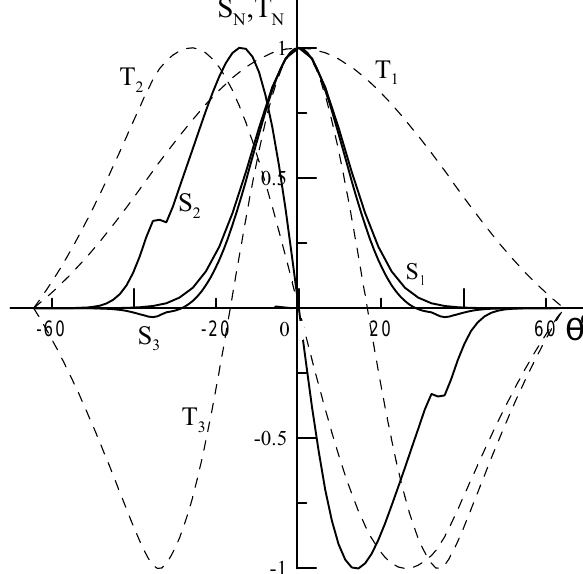
Fig. 4. Structure along the magnetic field lines of the first three har- monics of standing Alfv´en waves T N (θ) ( N = 1 , 2 , 3) (dashed lines) and SMS waves S N (θ) ( N = 1 , 2 , 3) (solid lines) at the magnetic shell a = 6 . 6 R E . Both functions are normalized to